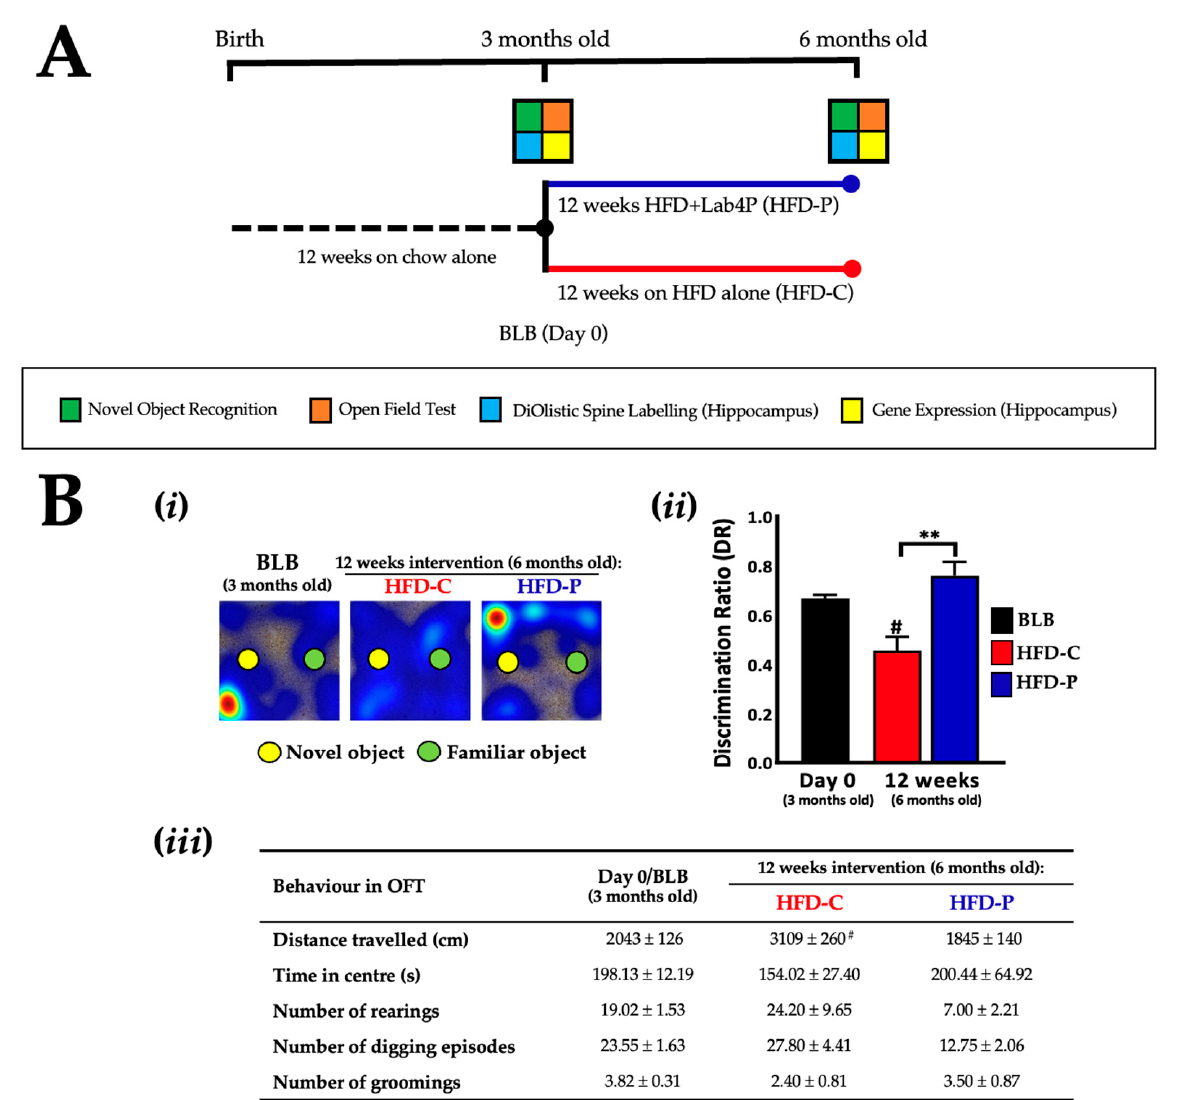
Figure 3. The impact of 12 weeks supplementation with Lab4P on cognition of 3xTg-AD mice on a high fat diet (Study B). ( A ) 3xTg-AD study design and test/sample collection schedule. 3-month-old male 3xTg-AD mice received high fat diet with or without Lab4P for 12 weeks. ( Bi ) Representative heat maps of mouse movements and ( Bii ) changes from baseline (BLB) in discrimination ratio (DR) as determined during Novel Object Recognition (NOR) testing or ( Biii ) changes from baseline in behaviour during open field testing (OFT) of 3xTg-AD mice receiving HFD alone (HFD-C) or HFD plus Lab4P (HFD-P) for 12 weeks. Data are expressed as mean ± standard error of the mean (SEM). Mouse numbers for each data point/group were: 61 mice (Day 0), 5 mice (HFD-C) and 4 mice (HFD-P) (12 weeks). Values of p were determined using one-way ANOVA with Tukey’s post hoc analysis or the Kruskal–Wallis test with Dunn’s post hoc analysis where ** indicated p < 0.01 versus the control or # p < 0.05 versus baseline.